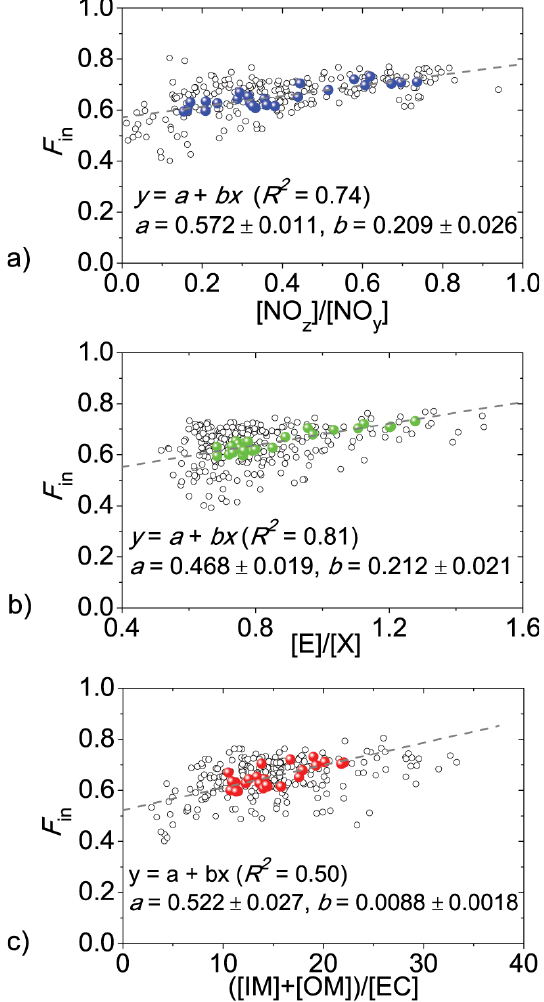
Fig. 8. Correlations between F in and (a) [ NO z ] / [ NO y ] , (b) [ E ] / [ X ] , and (c) ( [ IM ]+[ OM ] )/ [ EC ] . The open circles are measurement data with a time resolution of 1h; while the colored solid dots are average diurnal data. The average diurnal data can be linearly fitted by equation “ y = a + bx ” (dashed line) with R being the correlation coefficient.